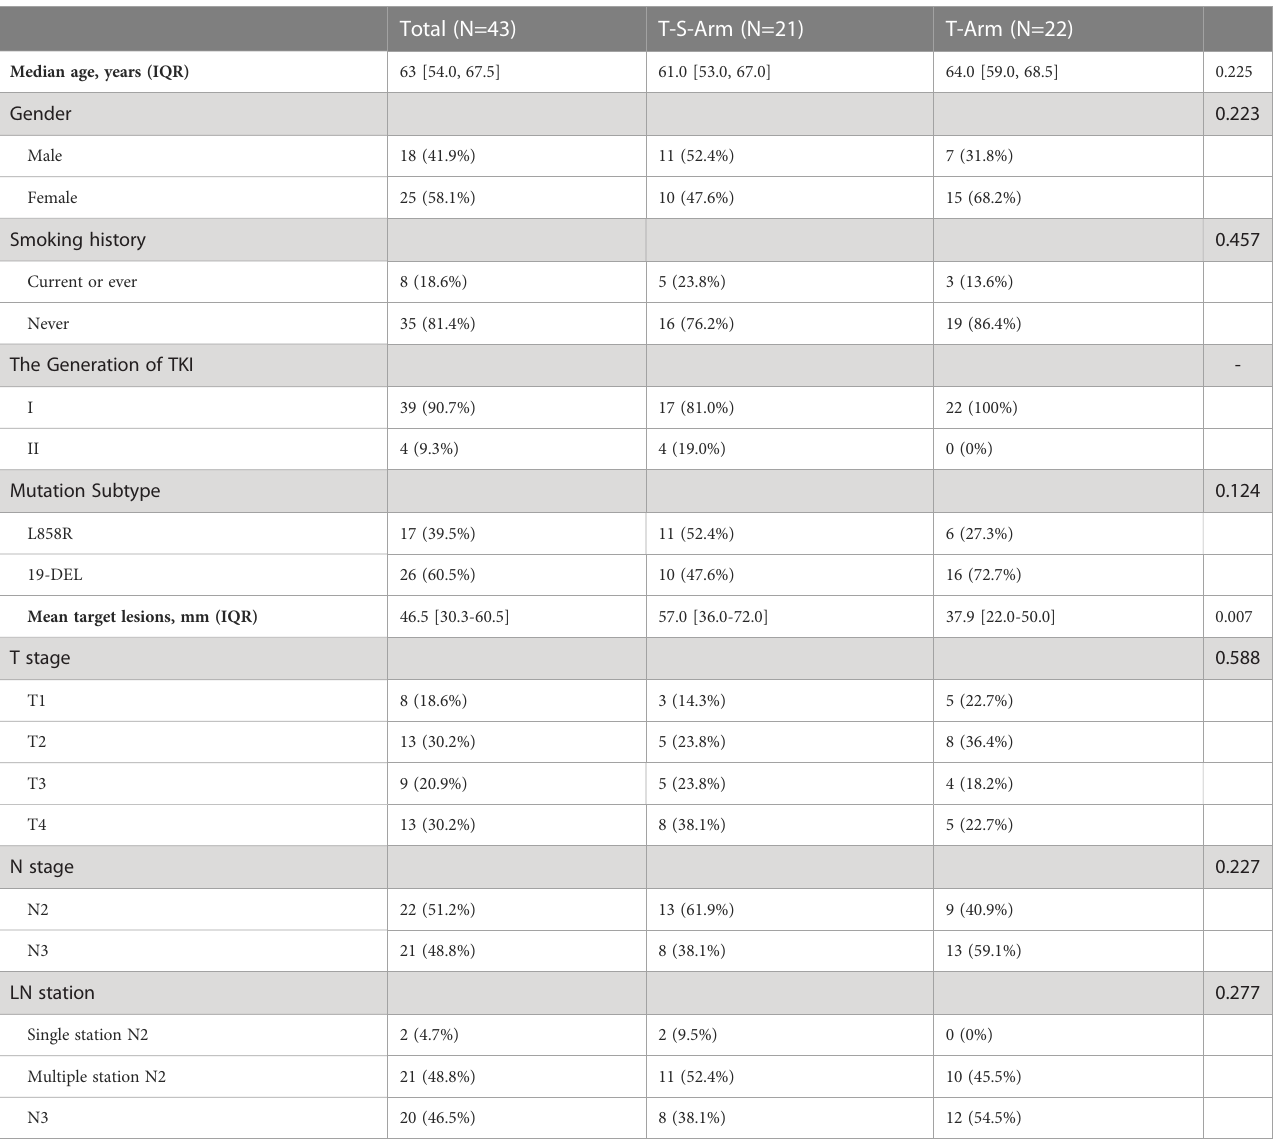
TABLE 1 Baseline information of patients receiving EGFR